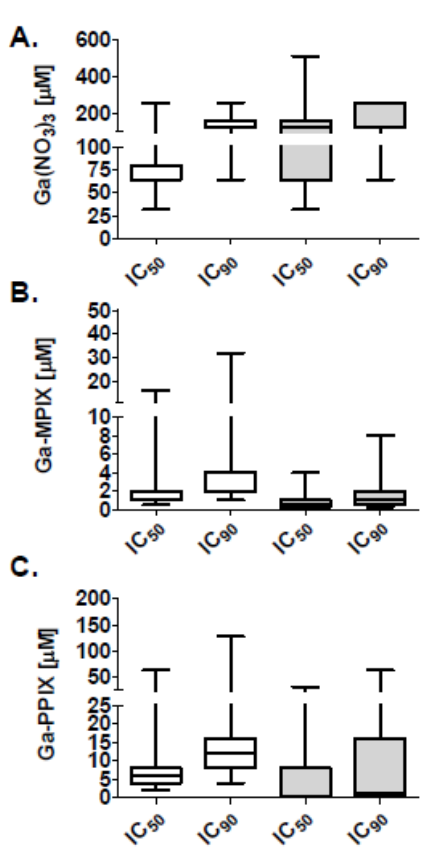
Figure 3. Inhibitory activities of Ga-MPIX and Ga-PPIX on a planktonic MDR A. baumannii isolates. Genotypically distinct isolates of A. baumannii ( n = 13) were grown in the iron deplete medias, MHB II (0.3 g/L) (un-shaded boxes) or RPMI1640 (shaded boxes), and exposed to different concentrations (0–512 µM) of ( A ) Ga(NO 3 ) 3 ; ( B ) Ga-MPIX; or ( C ) Ga-PPIX for 24 h. Plots show the concentrations (µM) required to reduce viable bacteria of individual isolates by 50% (IC 50 ) and 90% (IC 90 ). Boxes represent medians; whiskers represent range of strains tested.